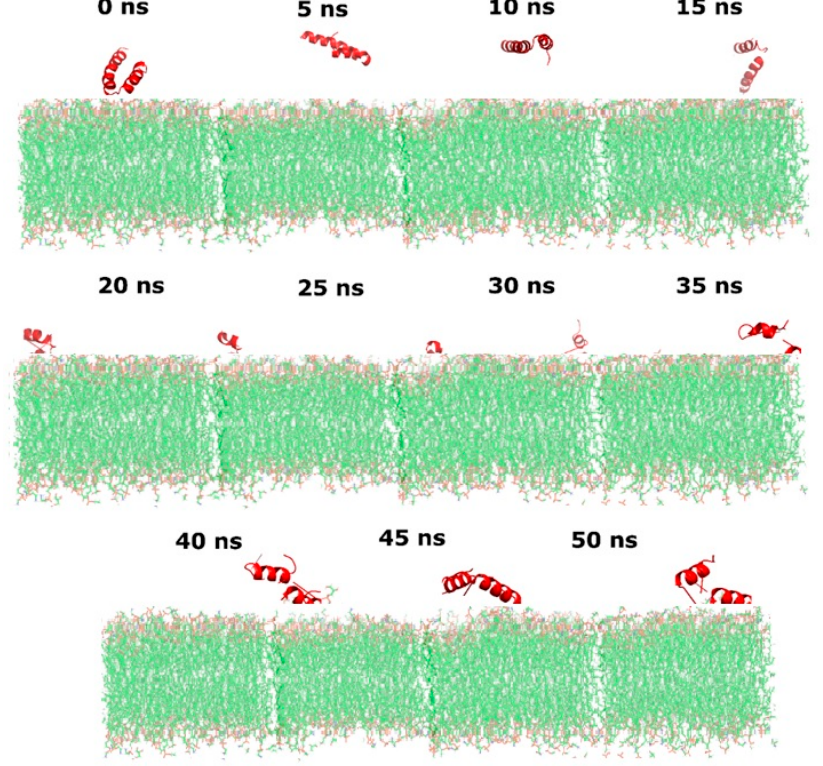
Figure 6. Dynamics of interaction between ∆ M2 peptide and colistin-resistant Pseudomonas (CRPa) model membrane for 50 nanoseconds.